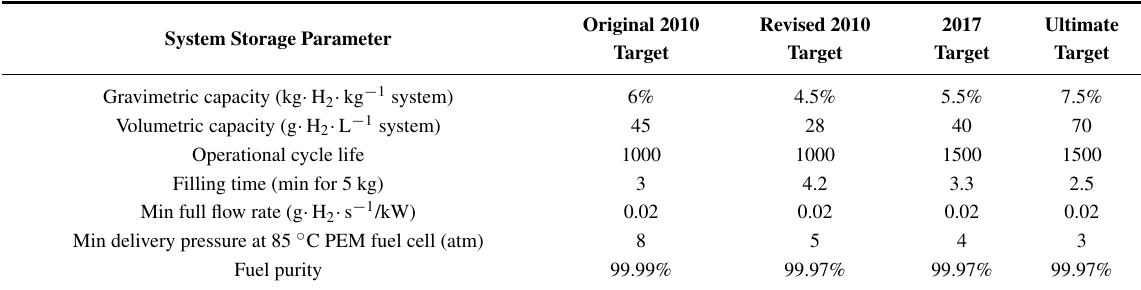
Table 1. Department of Energy (DoE) requirements for hydrogen storage system for mobile application [8]. PEM: proton exchange